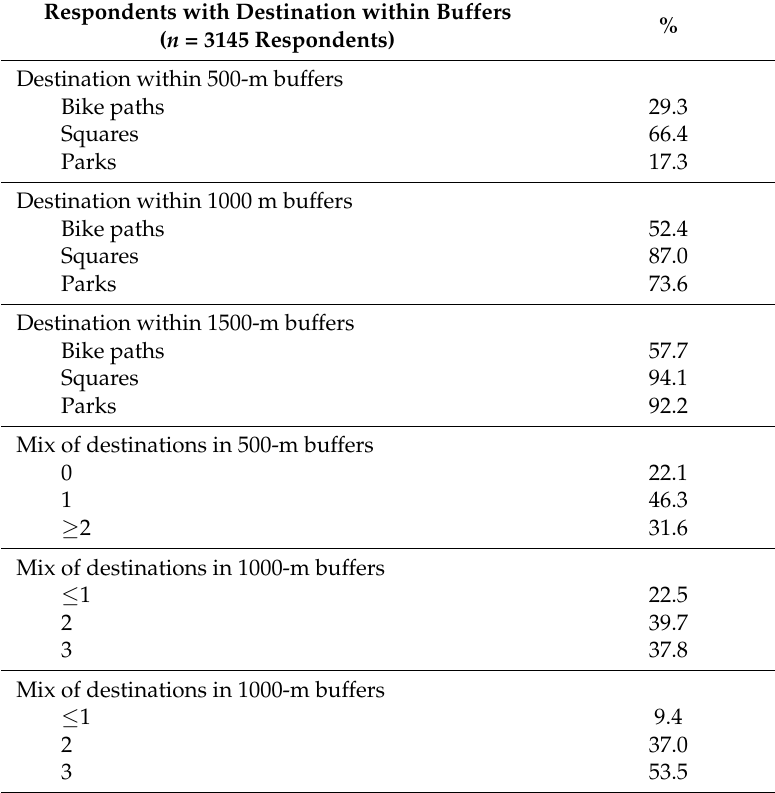
Table 2. Descriptive statistics of the destination to open spaces for geocoded sample according to buffer size, Sao Paulo,